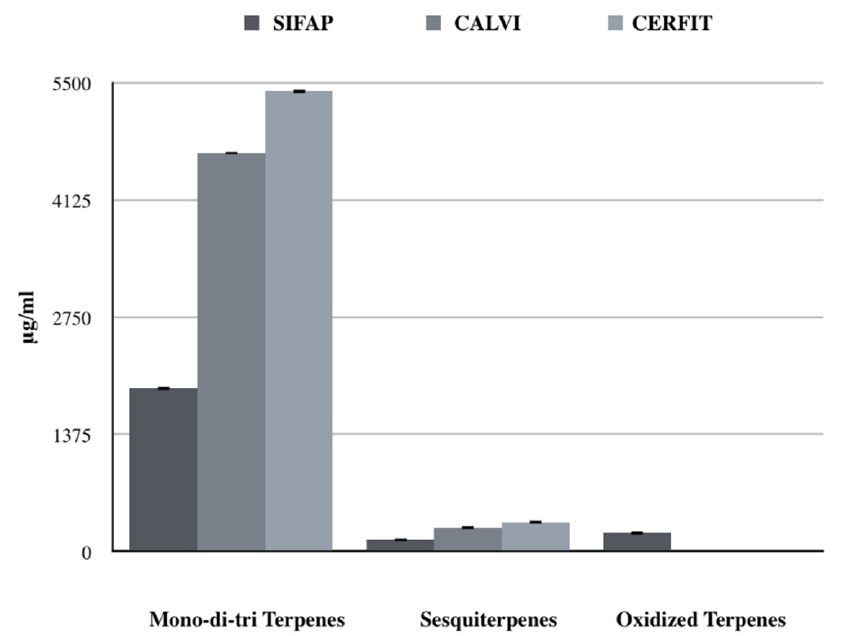
Figure 4. Comparison of terpene classes’ concentrations (µg/mL) obtained with the three different extraction method.